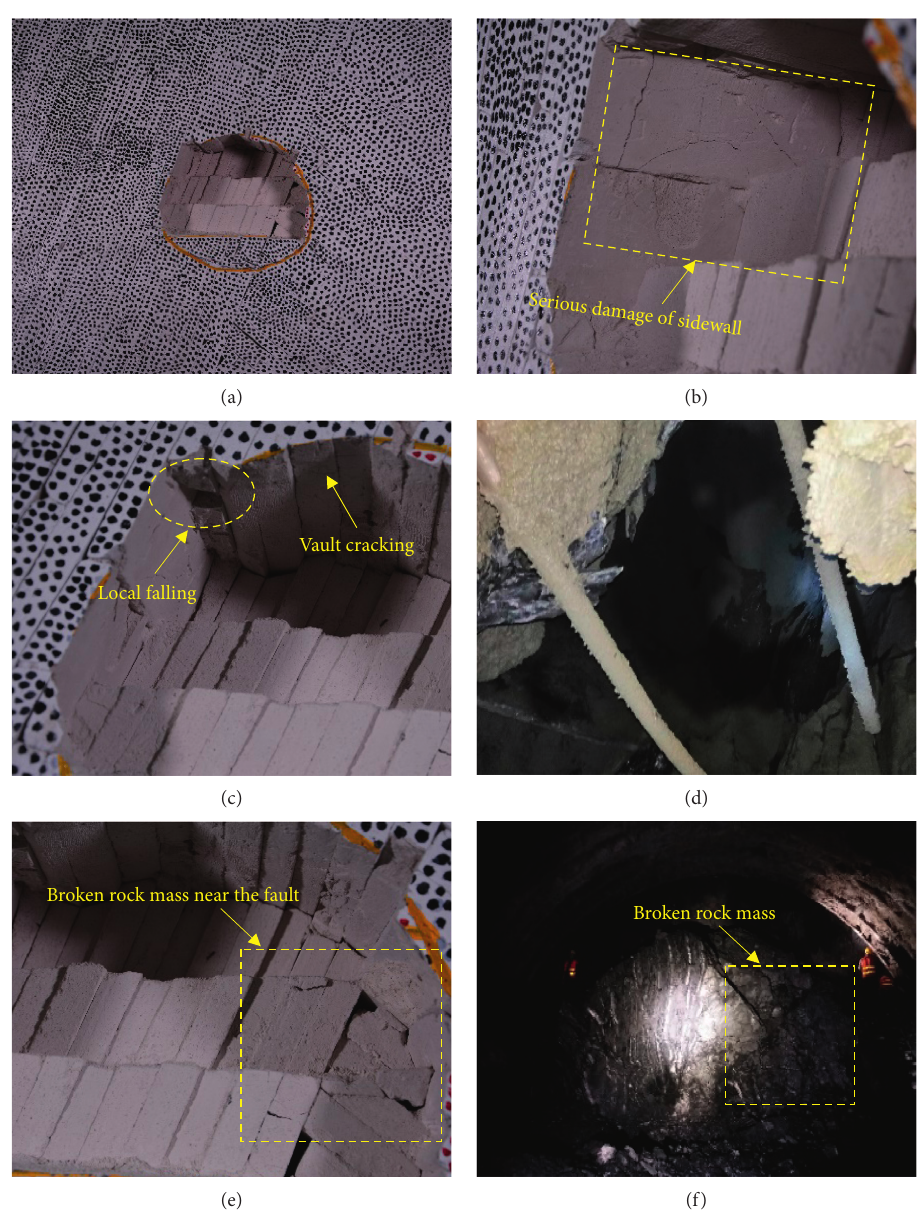
Figure 10: Third excavation stage (E5 and E6) and deformations of surrounding